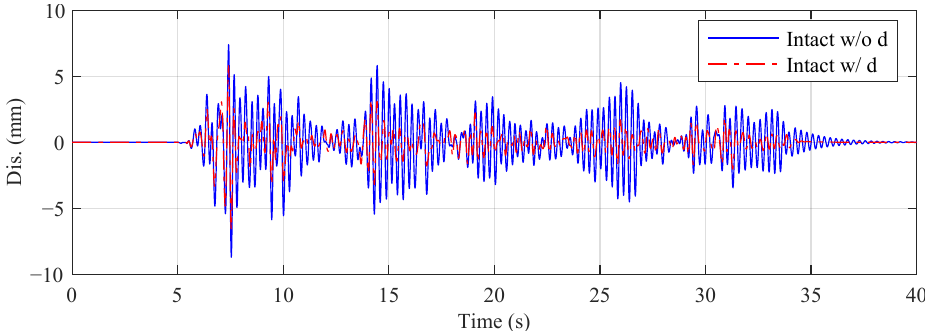
Figure 8. Third-floor displacement responses of Intact w/o d and Intact w/ d (El Centro earthquake, Case